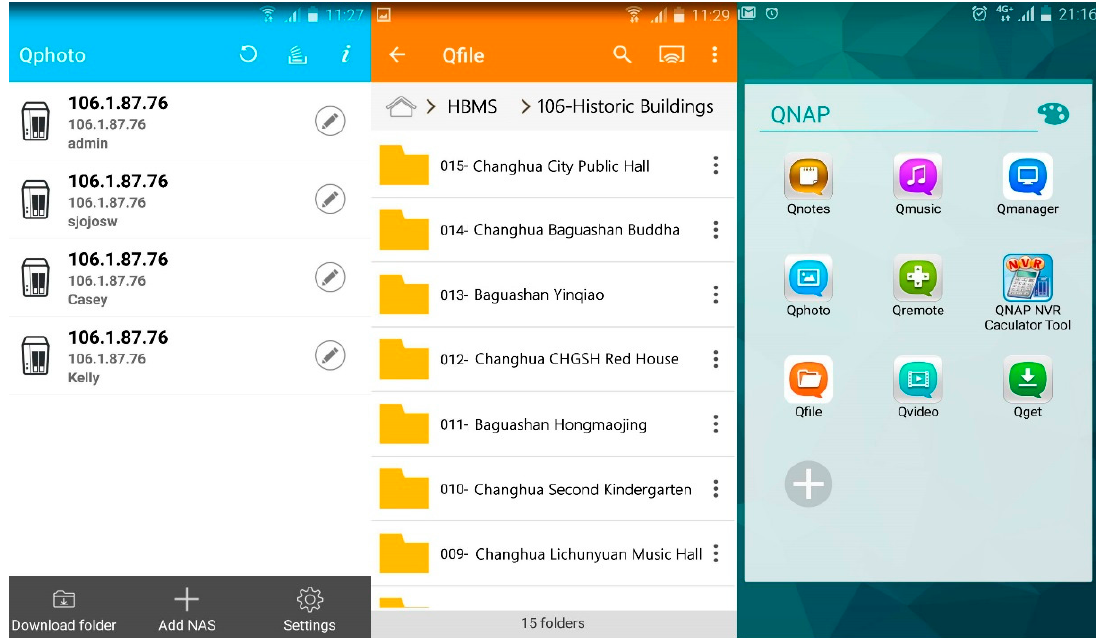
Figure 3. Downloadable free apps.